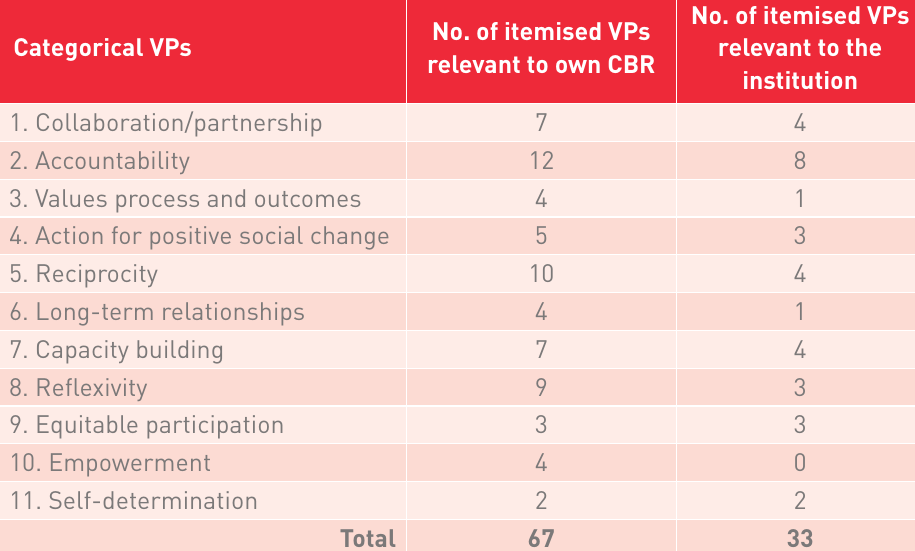
VPs relevant to CBR Categorical VPs